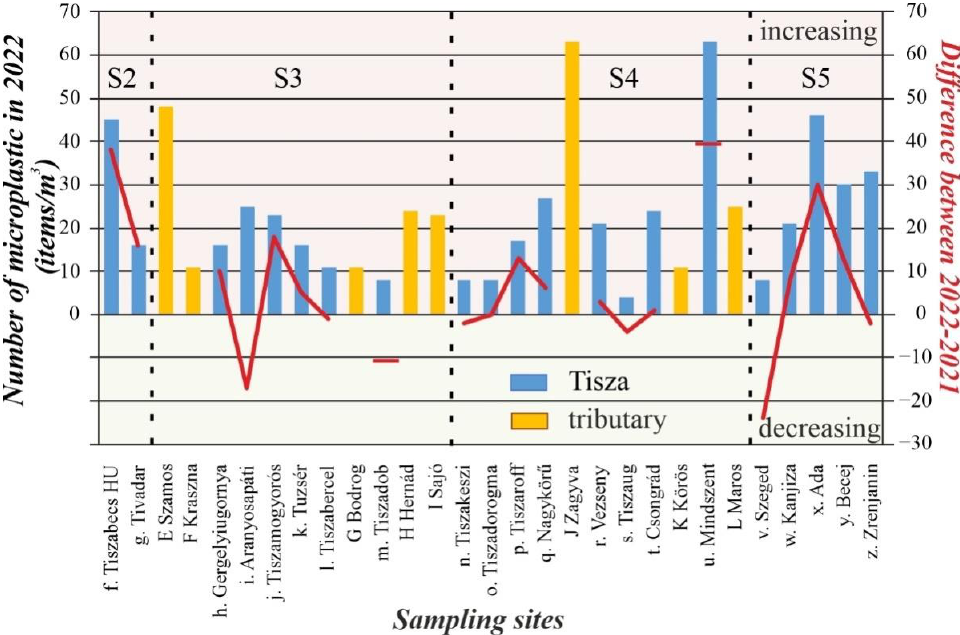
Figure 5. The amount of transported microplastics in the fluvial system of the Tisza in 2022, and the difference between the data of the surveys made in 2021 and 2022.